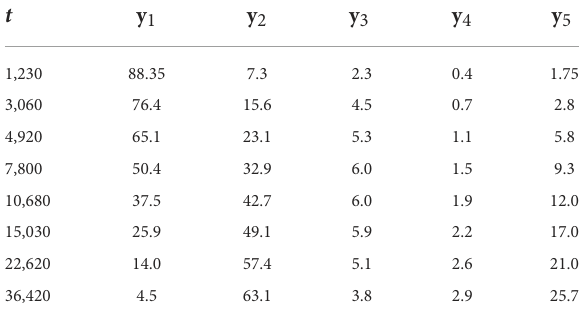
TABLE 2 Data for α − pinene concentrations from Fuguitt and Hawkins